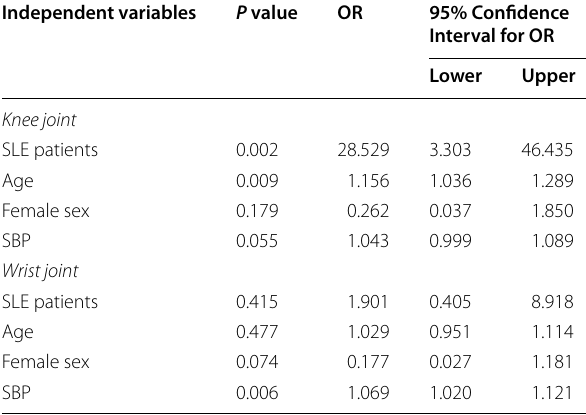
Table 4 Binary logistic regression analysis for prediction of the presence of abnormal findings by the US in the knee and wrist joint from different risk factors (SLE, age, female sex, and SBP) Independent variables P value OR 95% Confidence Interval for OR